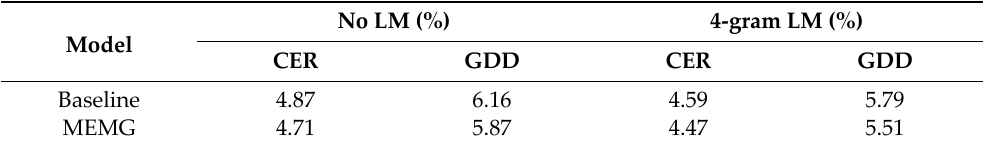
Table 5. Model comparison with language model on AISHELL‑1.